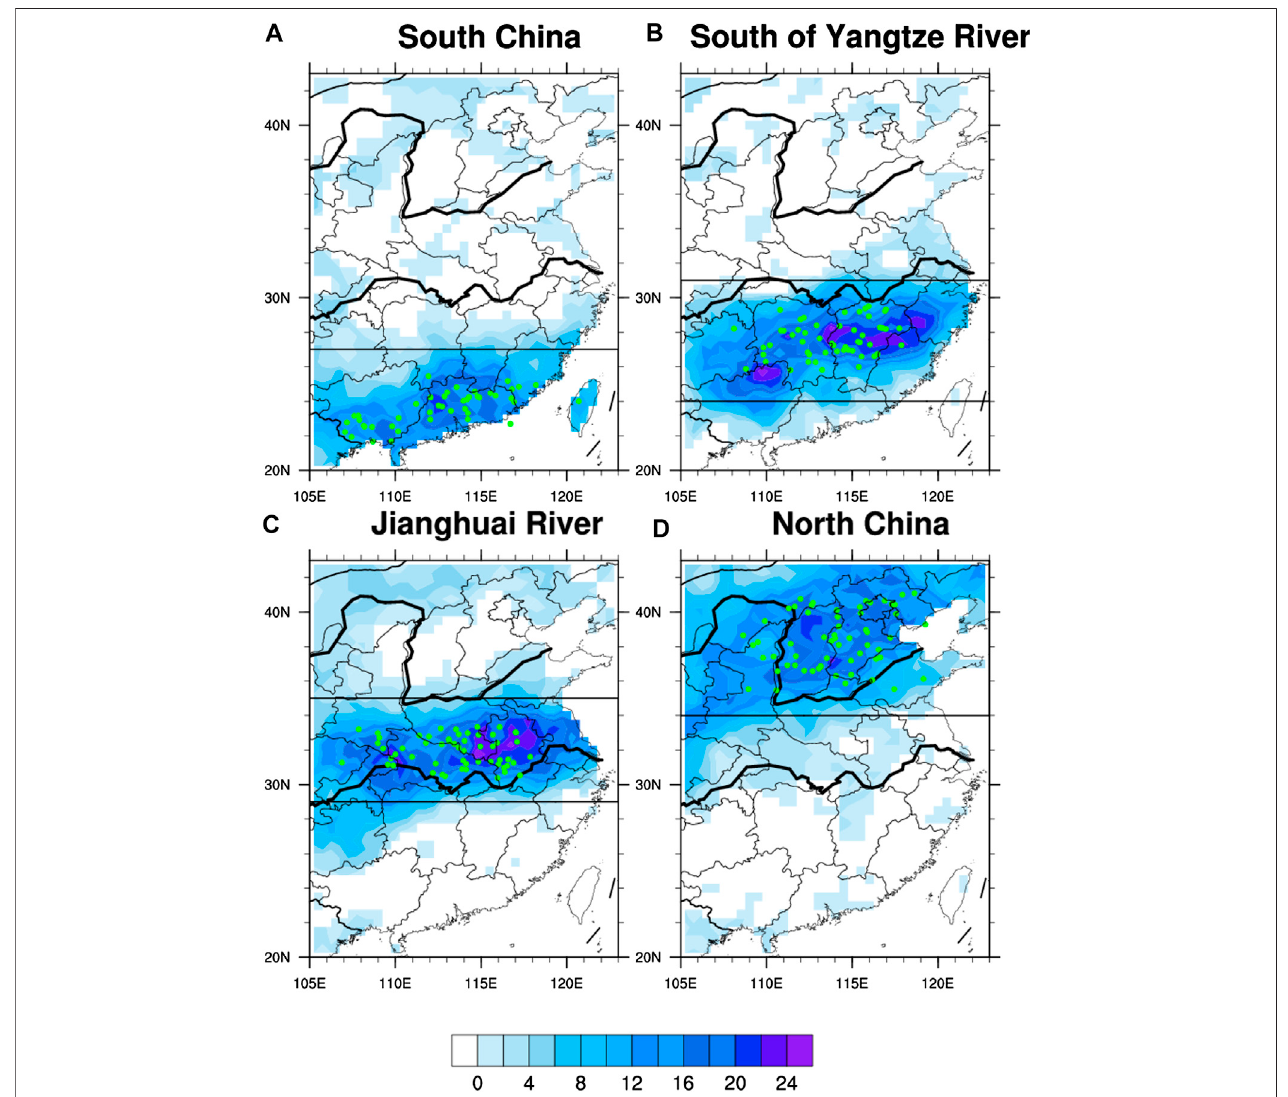
FIGURE2| Thefrequency(shading)and centerofgravity(green dot)ofRPEP inSC (A) ,SYR (B) ,JHR (C), andNC (D) .Theblackboxindicates thespeci fi ccluster region.